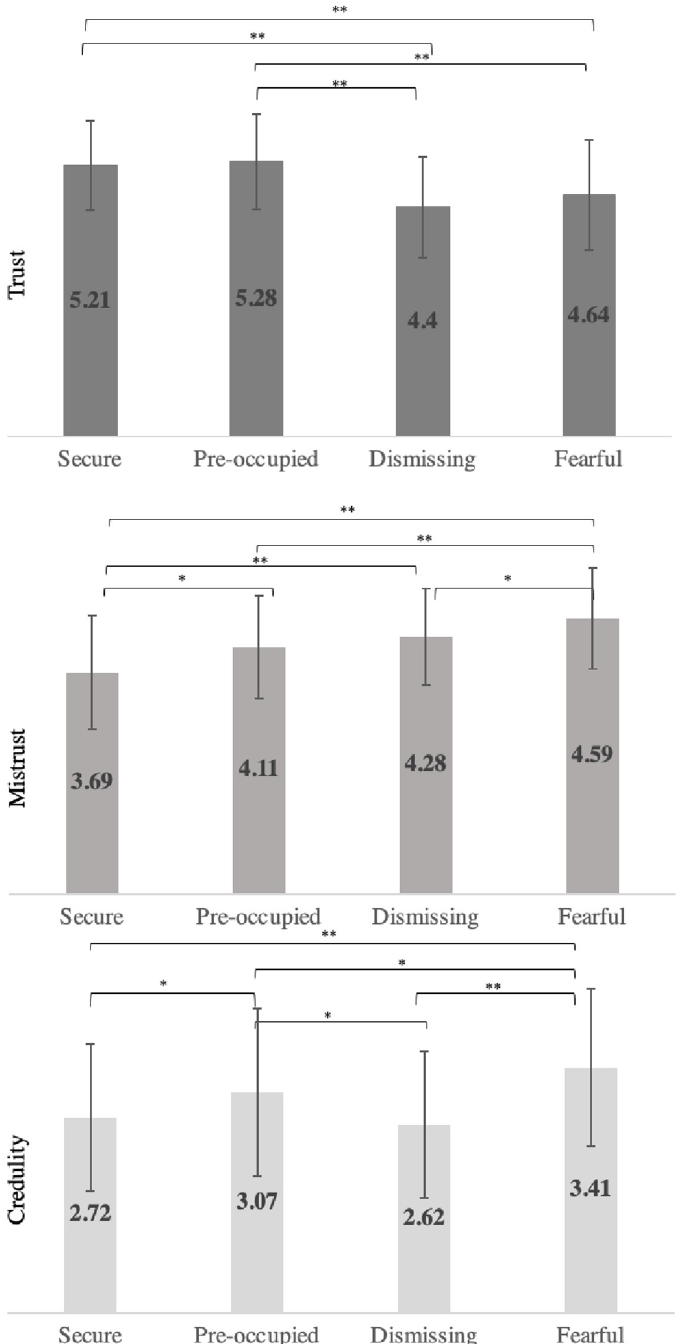
Fig 3. Comparison of ET subscales scores between attachment groups (p values are corrected for multiple comparisons). � p < 0 . 05 . �� p < 0 . 001 .